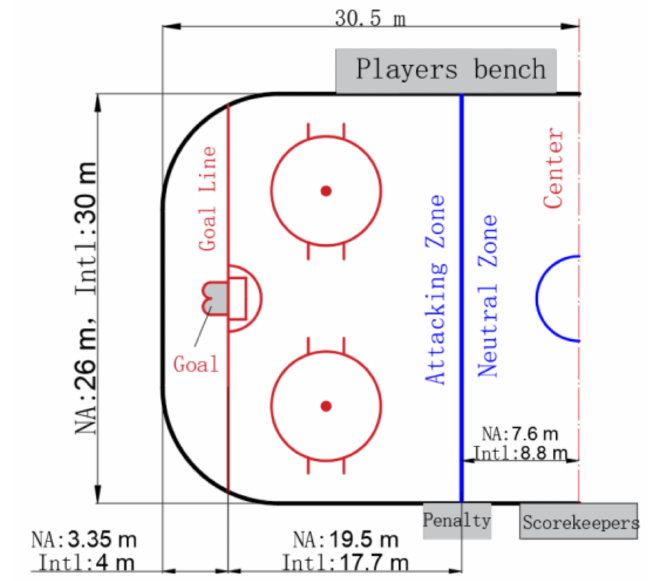
Figure 1. Typical hockey rink geometry parameters (half layout).